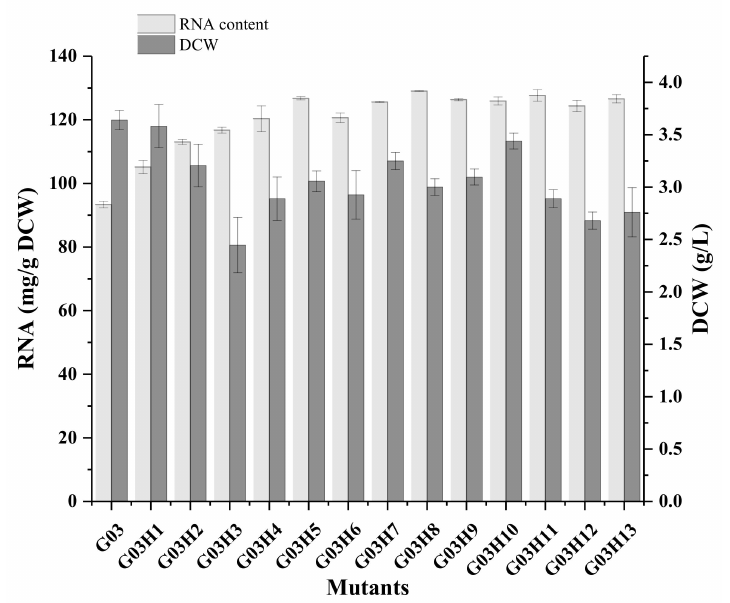
Figure 2. RNA content and growth of the different mutants. Data are the average of three independent experiments. Error bars represent ±